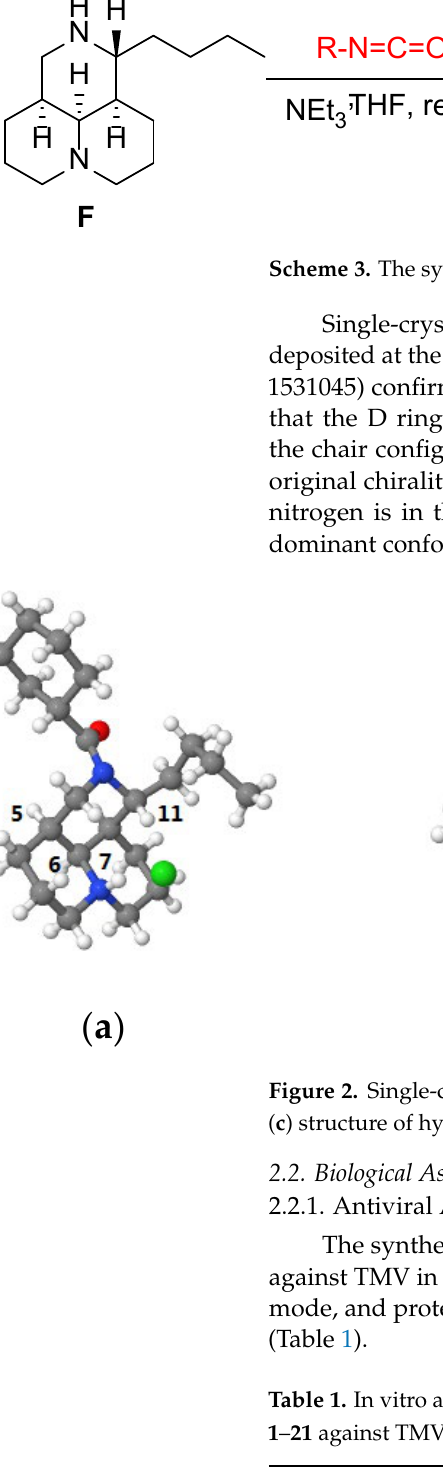
Scheme 3. The synthetic route for matrine derivatives 20 and 21 .